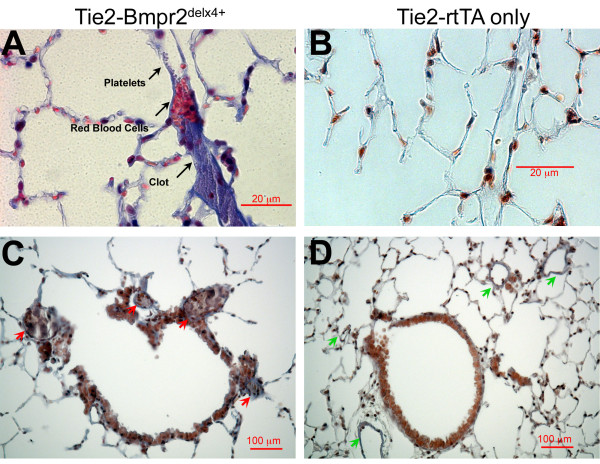
Tie2-Bmpr2delx4+ mouse lung has strongly increased frequency of thromboses in both small (A) and large (C) vessels. We have never seen these in control lungs (B and D for comparison). Lungs were prepared with Carstairs' stain as described in the methods section